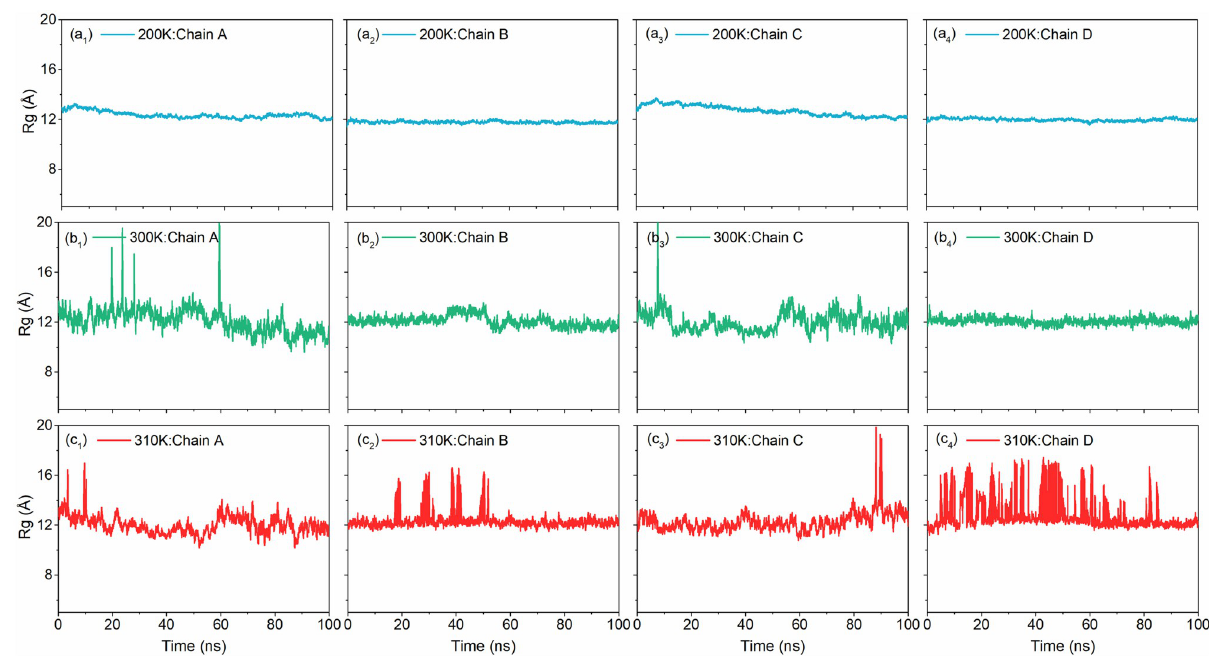
Fig 4. Variation of radius of gyration (Rg) of all the strands of the DNA Junction with simulation time at(a) 200K, (b) 300K, and (c) 310K